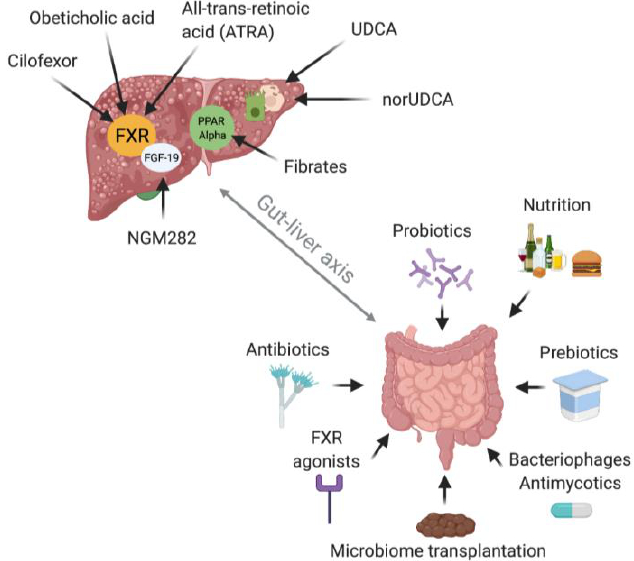
Figure 2. Therapeutic strategies. Current treatment options to modulate the gut microbiome in liver diseases and approved and investigated drugs targeting bile acids for chronic cholestatic liver diseases. Accepted options to therapeutically influence microbiome composition and therefore the gut-liver axis are probiotics, prebiotics, antibiotics, FMT, and nutrition. Antimycotics and Bacteriophages are still in the explorative stage, same as FXR agonists concerning their potential to modulate the gut microbiome. Approved drugs for the treatment of PBC include UDCA, obeticholic acid and fibrates. No approved drugs are available for the treatment of PSC and SC-CIP. NorUDCA, all trans-retinoic acid, cilofexor, other PPAR ligands, and NGM282 are still under investigation. Created with BioRender.com. FXR = Farnesoid X receptor, FGF-19 = Fibroblast growth factor 19, PPAR = Peroxisome proliferator-activated receptor, NGM282 = an engineered fibroblast growth factor 19 analogue, UDCA = Ursodeoxycholic acid, norUDCA = norUrsodeoxycholic